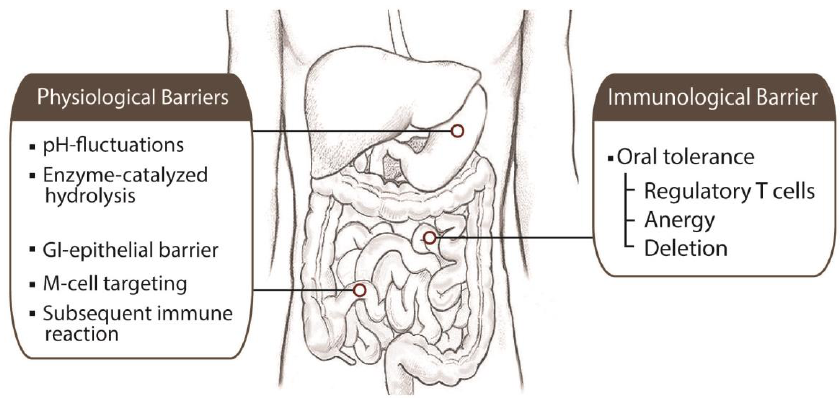
Figure 2. Physiological and immunological barriers to oral vaccine delivery. The different regions of